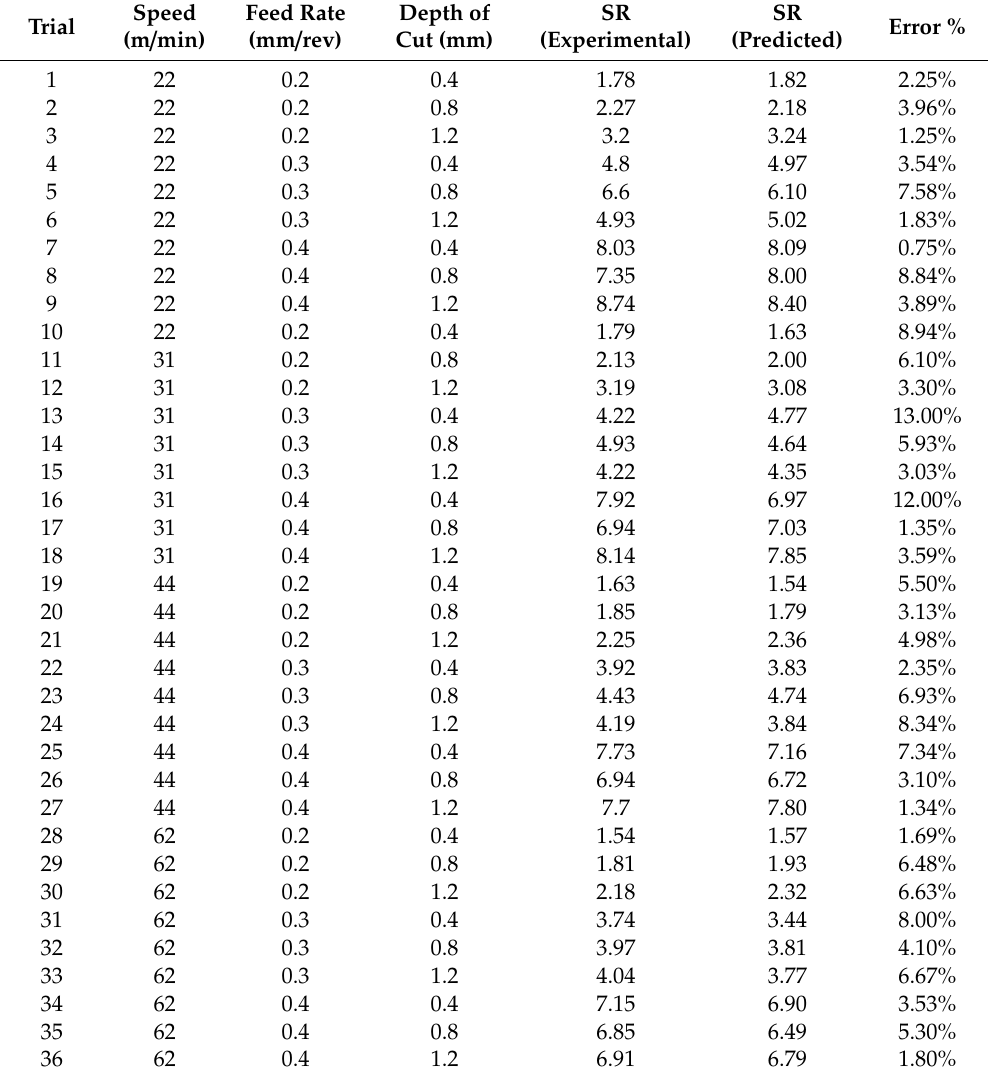
Table 6. ANFIS-QPSO prediction results of the surface roughness values for the dry turning process.